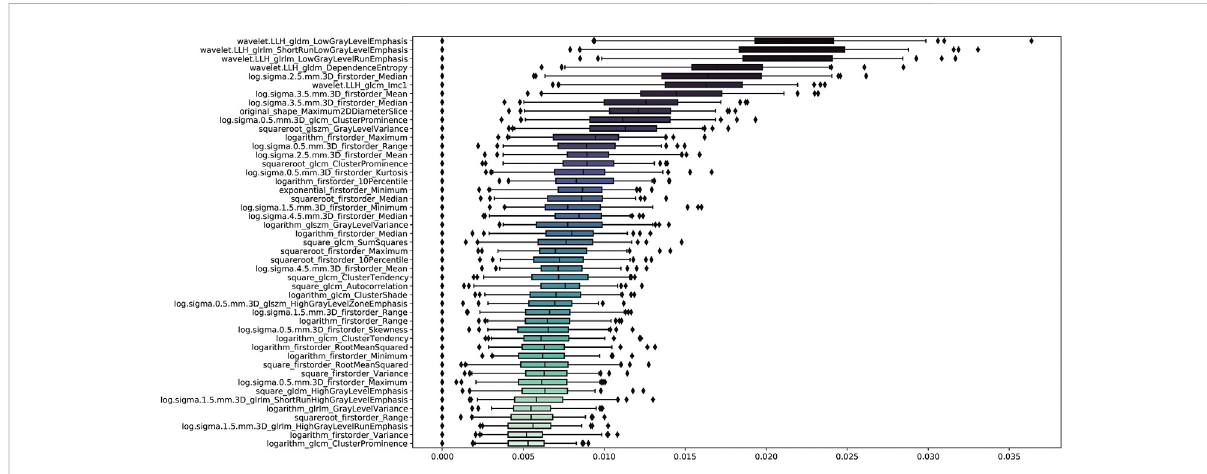
FIGURE 3 Importance ranking of 47 relevant radiomic features identi fi ed by Boruta algorithm in the training group. GLDM, gray level dependence matrix; GLRLM, gray level run length matrix; GLCM, gray level co-occurrence matrix; GLSZM, gray level size zone matrix.